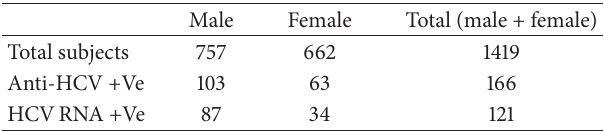
Figure 1: (a) Screening of samples for HCV RNA by amplifying 5 󸀠 UTR. Lanes 1, 2, and 3: positive samples (232 bp band of 5 󸀠 UTR), Lane 4: negative sample, Lane 5: negative control, Lane 6: positive control, and Lane M: 100 bp DNA ladder. (b) Amplified products of different HCV genotypes. Lane 1 = 139 bp (HCV genotype 2a), Lane 2 = 176 bp HCV genotype 3b, Lane 3 = 232 bp (HCV genotype 3a), Lane 4 = 176 and 232 bp (HCV genotypes 3b and 3a), Lane 5 = 176 bp HCV genotype 3b, Lane 6 = 232 and 99 bp (HCV genotypes 3a and 4), and Lane M = 100 bp DNA ladder. Table 1: Screening general population of Mardan for anti-HCV and HCVRNA.